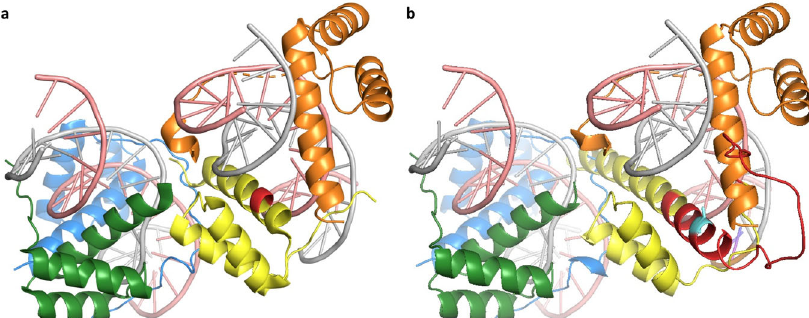
Fig. 5 The effect of the NOBOX 3 ′ splice site extension on protein structure. a The image shows the crystal structure of Drosophila melanogaster Aristaless and Clawless homeodomain proteins bound to DNA (PDB: 3A01). The Aristaless protein (chain F, yellow) has 57% identity to the NOBOX homeobox domain. The residues where the 32 amino acid insert would break the NOBOX homeobox domain are highlighted in red. The insertion is right next to the conserved DNA-binding residues of the homeobox domain and this primate-derived exon would almost certainly banish the NOBOX homeobox DNA-binding function. b The same PDB structure with the inserted exon modelled by AlphaFold for the UniProtKB NOBOX display isoform grafted onto the structure. The inserted exon is in red. The predicted effect of the insertion would be to extend the helix (again) and to interfere with the DNA-binding of the human Aristaless homologue. Mapping was carried out using HHPRED and both images were generated with